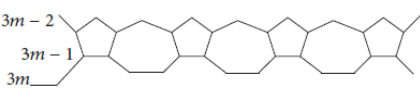
Figure 5. ith period of SC 5 C 7 [ p , q ]